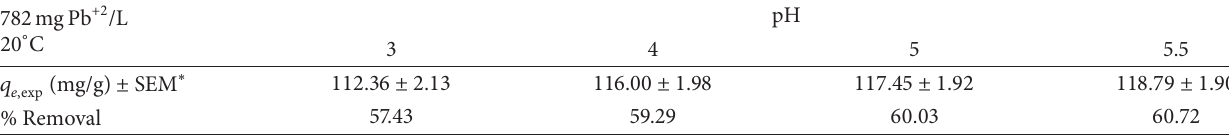
Table 4: Results of lead removal capacities at different pHs.